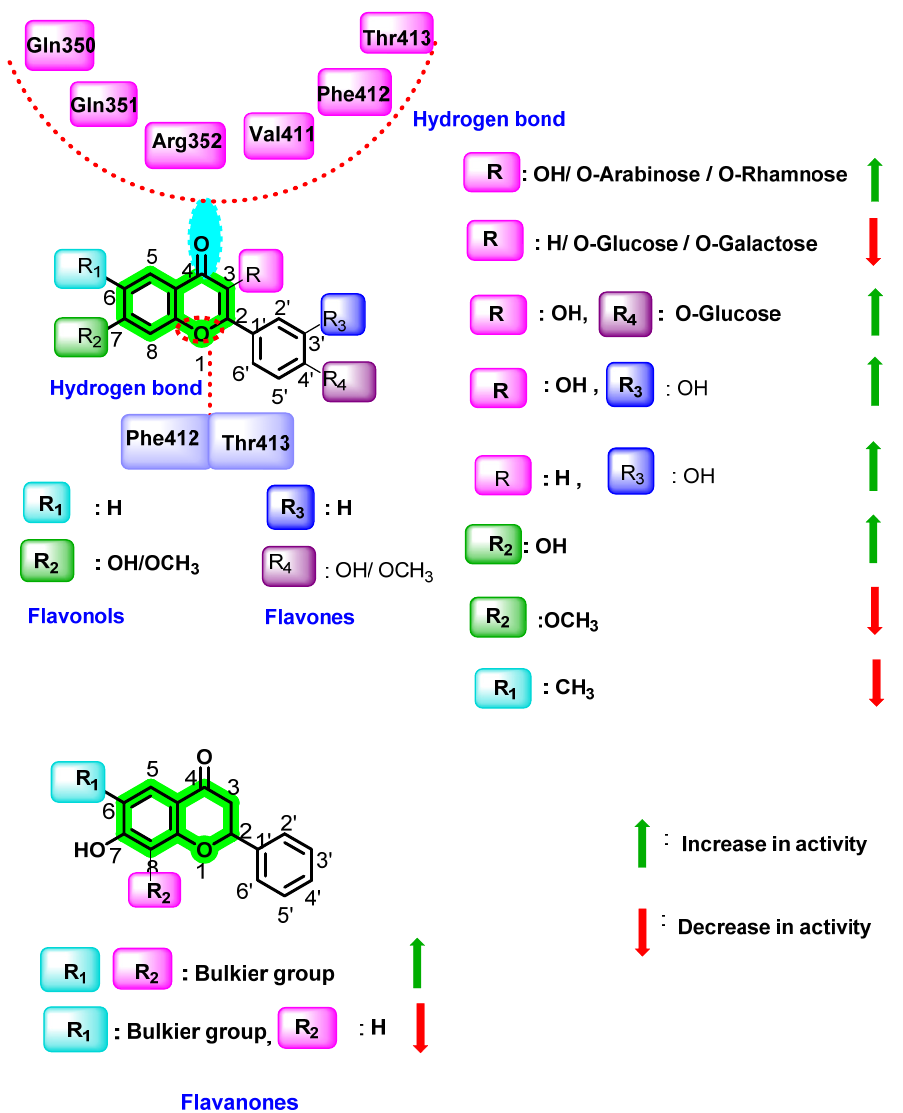
Figure 15. QSAR of flavonols, flavanones, and